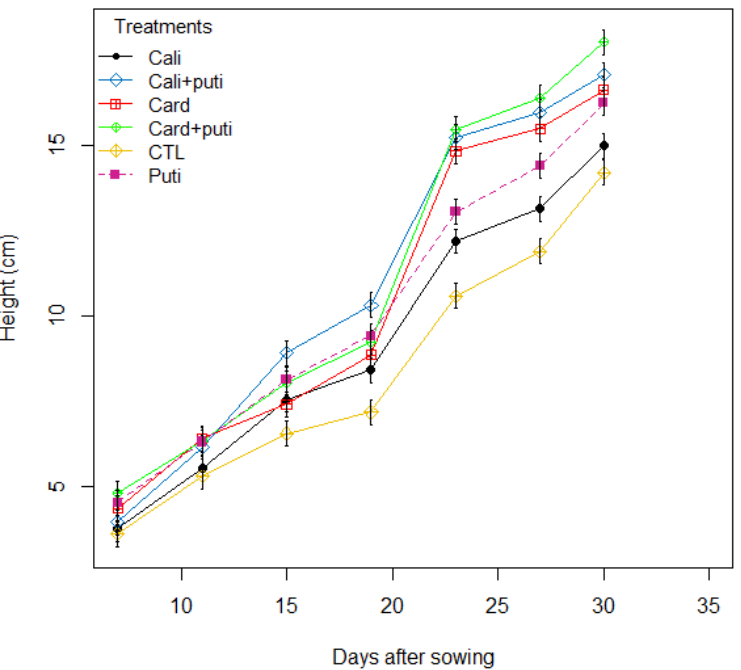
Figure 2. Plant height development as a function of treatments and overtime. CTL = Control (Uncoated seed (without chitosan and P. putida ); Cali = Seeds coated with chitosan extracted from Callinectes amnicola ; Card = Seeds coated with chitosan extracted from Cardisoma armatum ; Puti = Seeds inoculated with Pseudomonas putida ; Cali + puti = Seeds coated with the combination of Callinectes amnicola + Pseudomonas putida ; Card + puti = Seeds coated with the combination of Cardisoma armatum + Pseudomonas putida